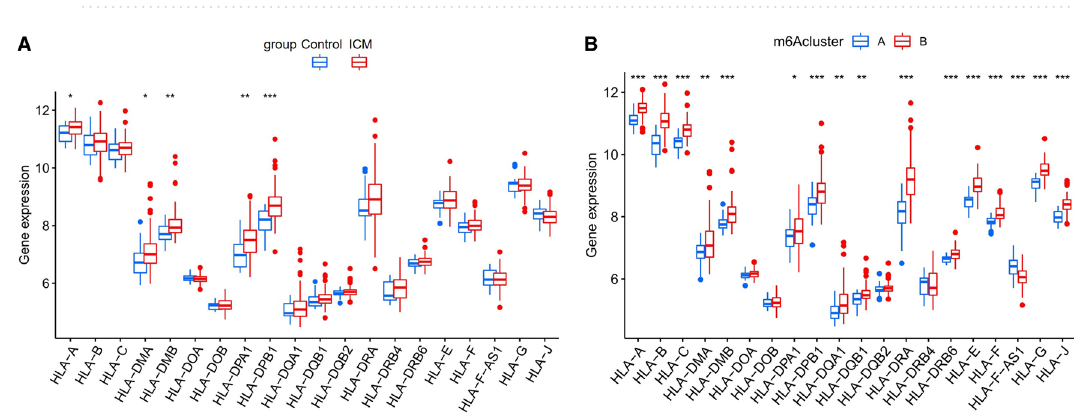
Figure 6. Comparison of immunocyte abundance in the high- and low-expression groups of YTHDF3 ( A ), FMR1 ( B ), ZC3H13 ( C ), RBM15 ( D ), YTHDC1 ( E ), FTO ( F ). *, P < 0.05; **, P < 0.01; ***, P < 0.001.